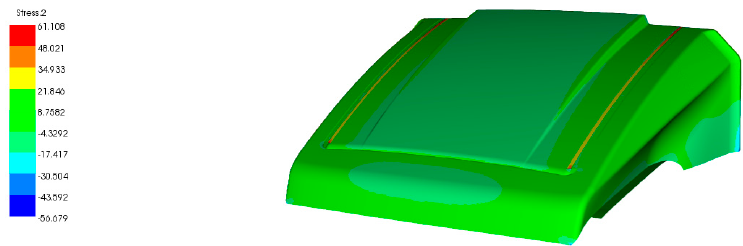
Figure 12. The result of buckling analysis.